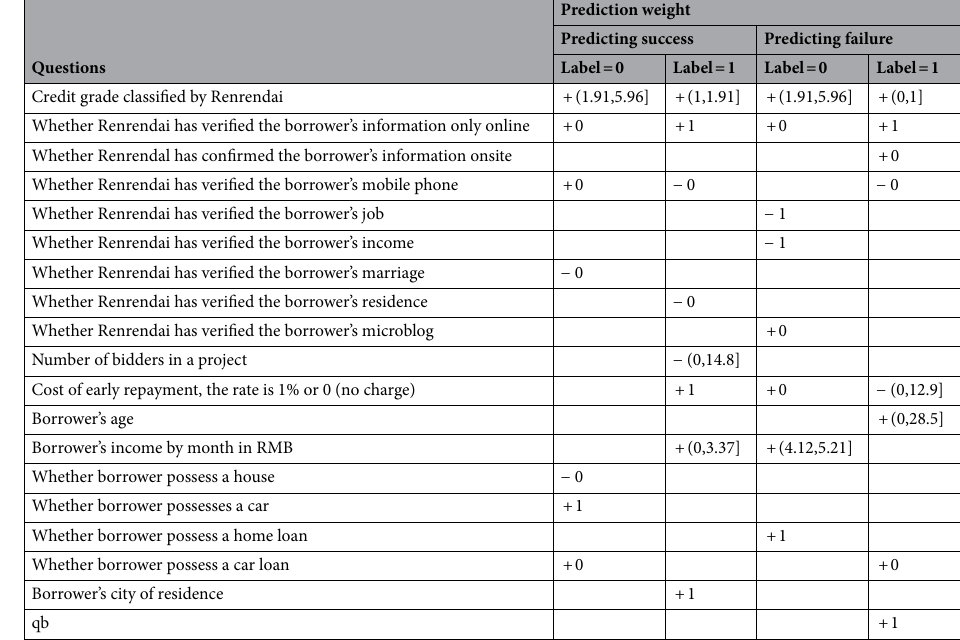
Figure 6. Variable weights of the RF model.